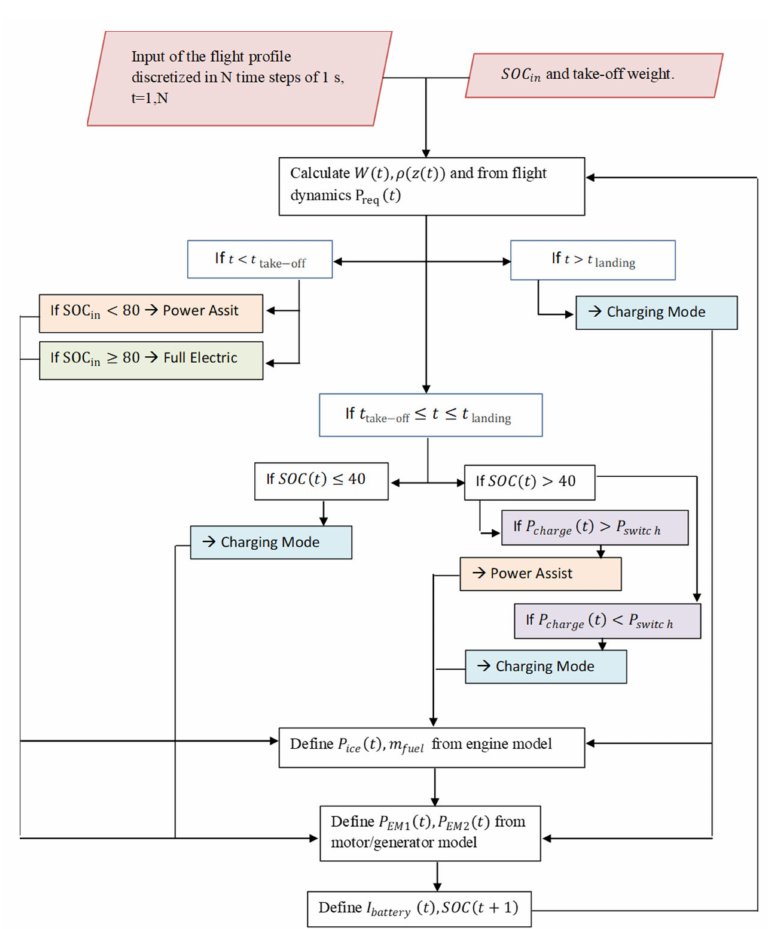
Figure A1. Flowchart of the energy management